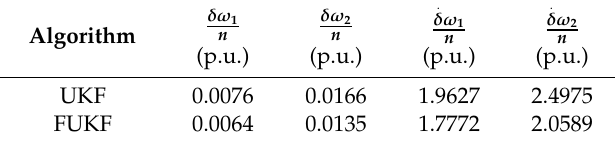
Table4. ValuesoftheestimationerrorsandtheirderivativesfortheUKFandFUKF—experimentalstudy.